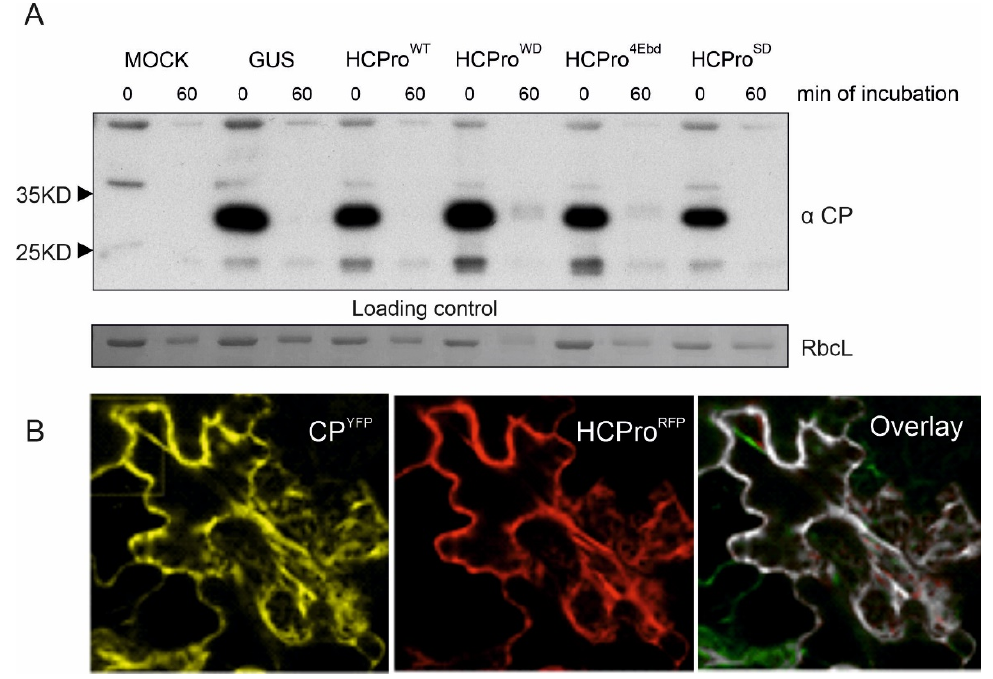
Figure 2. PVA HCPro alone does not increase CP stability in plant tissue lysate. ( A ) PVA CP was co-expressed with RFP-tagged versions of either PVA HCPro, HCPro WD , HCPro 4Ebd or HCPro SD , and the samples for western blot analysis were collected at 4 dpi. Neither HCPro nor its mutants were able to stabilize PVA CP in the in vitro degradation assay. Below is the loading control, Rubisco large subunit (RbcL) band stained with Ponceau S. ( B ) Both PVA HCPro RFP and CP YFP localized all over the cytoplasm when they were co-expressed. Given is also the overlay of the CP YFP and HCPro RFP fluorescence.